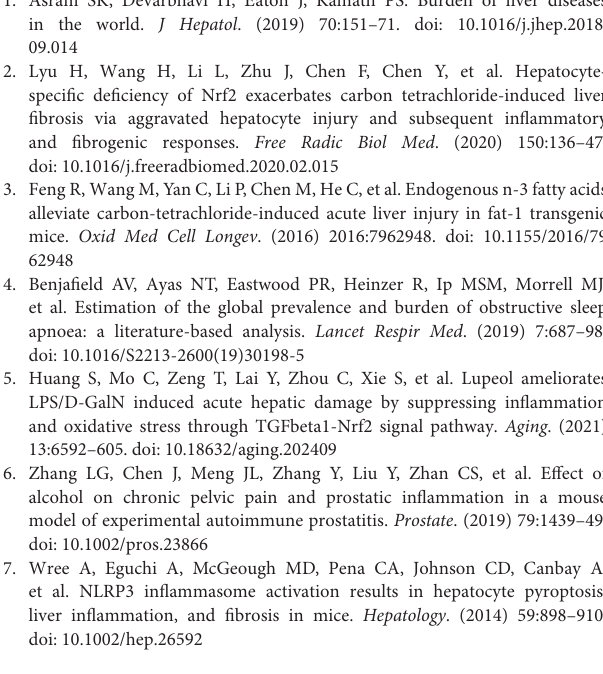
Supplementary Figure 1 | Representative images of MDSC in spleen, blood, and liver detected by flow cytometry in sham group pretreated with vehicle or MCC950 on days 1, 2, and 3. MDSC was marked as CD11b + Gr-1 +